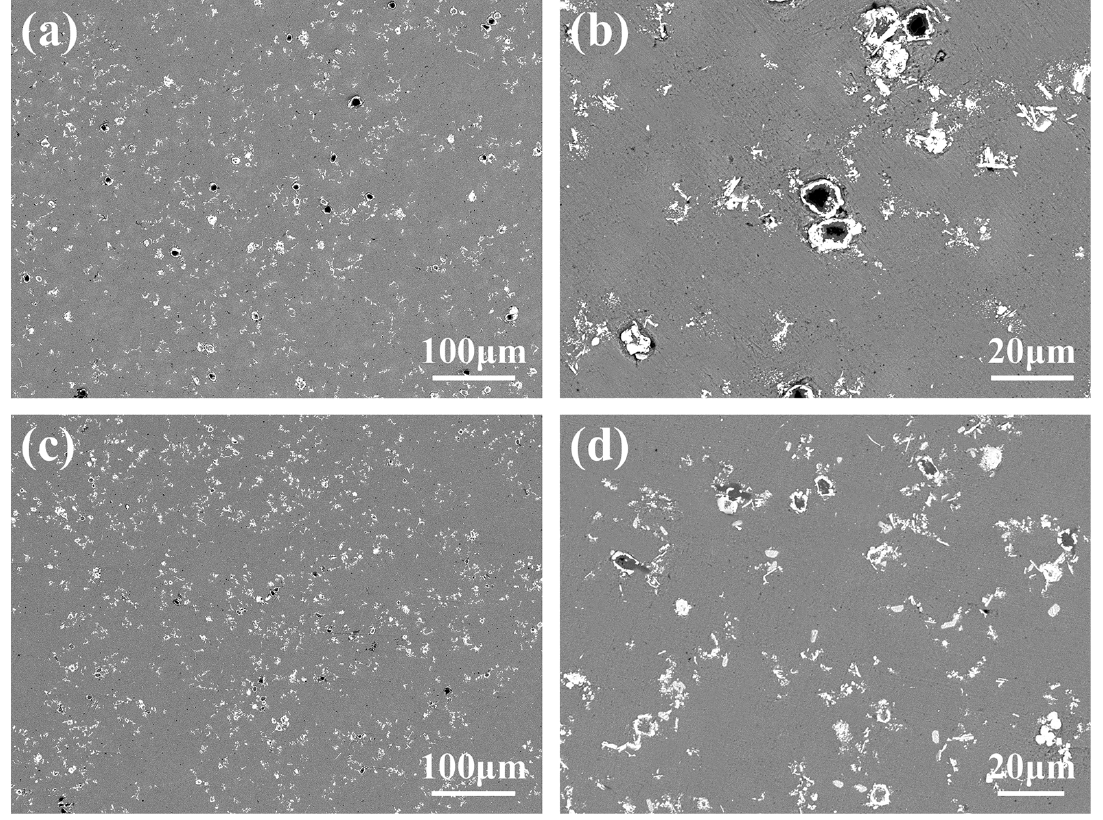
Figure 10. Microstructures of Al-4Ti-1C composites prepared by diamond with different sizes: ( a , b ) 10 μ m diamond and ( c , d ) 6 μ m diamond.